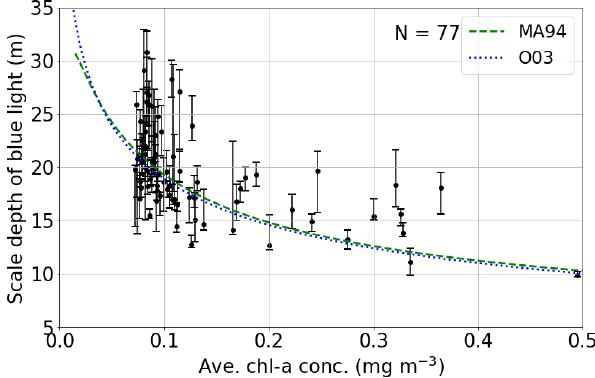
Figure 9. Observed h 2 against average chlorophyll a concentra- tion between the surface and 30m of depth from glider SG579 (black circles). Parameterizations of the scale depth of blue light (equivalent to h 2 ) for chlorophyll concentrations between 0 and 0.5mgm − 3 are presented with the observational data: Morel and Antoine (1994) (MA94) (dashed green line) and Ohlmann (2003) (O03) (dotted blue